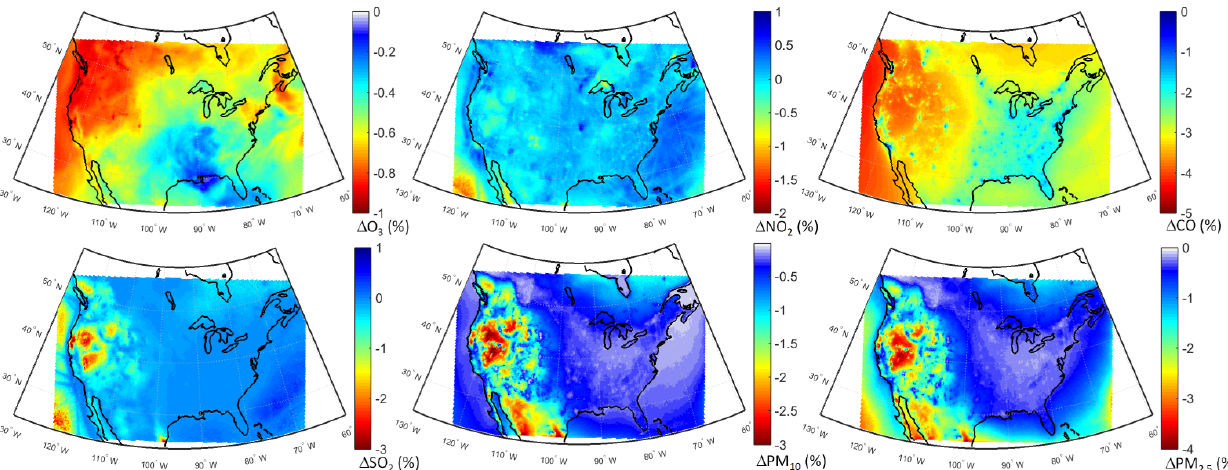
Figure 16. Spatial distribution of the annual mean relative differences between the East Asian emission perturbation scenario and the base case over North America as simulated by the multi-model mean